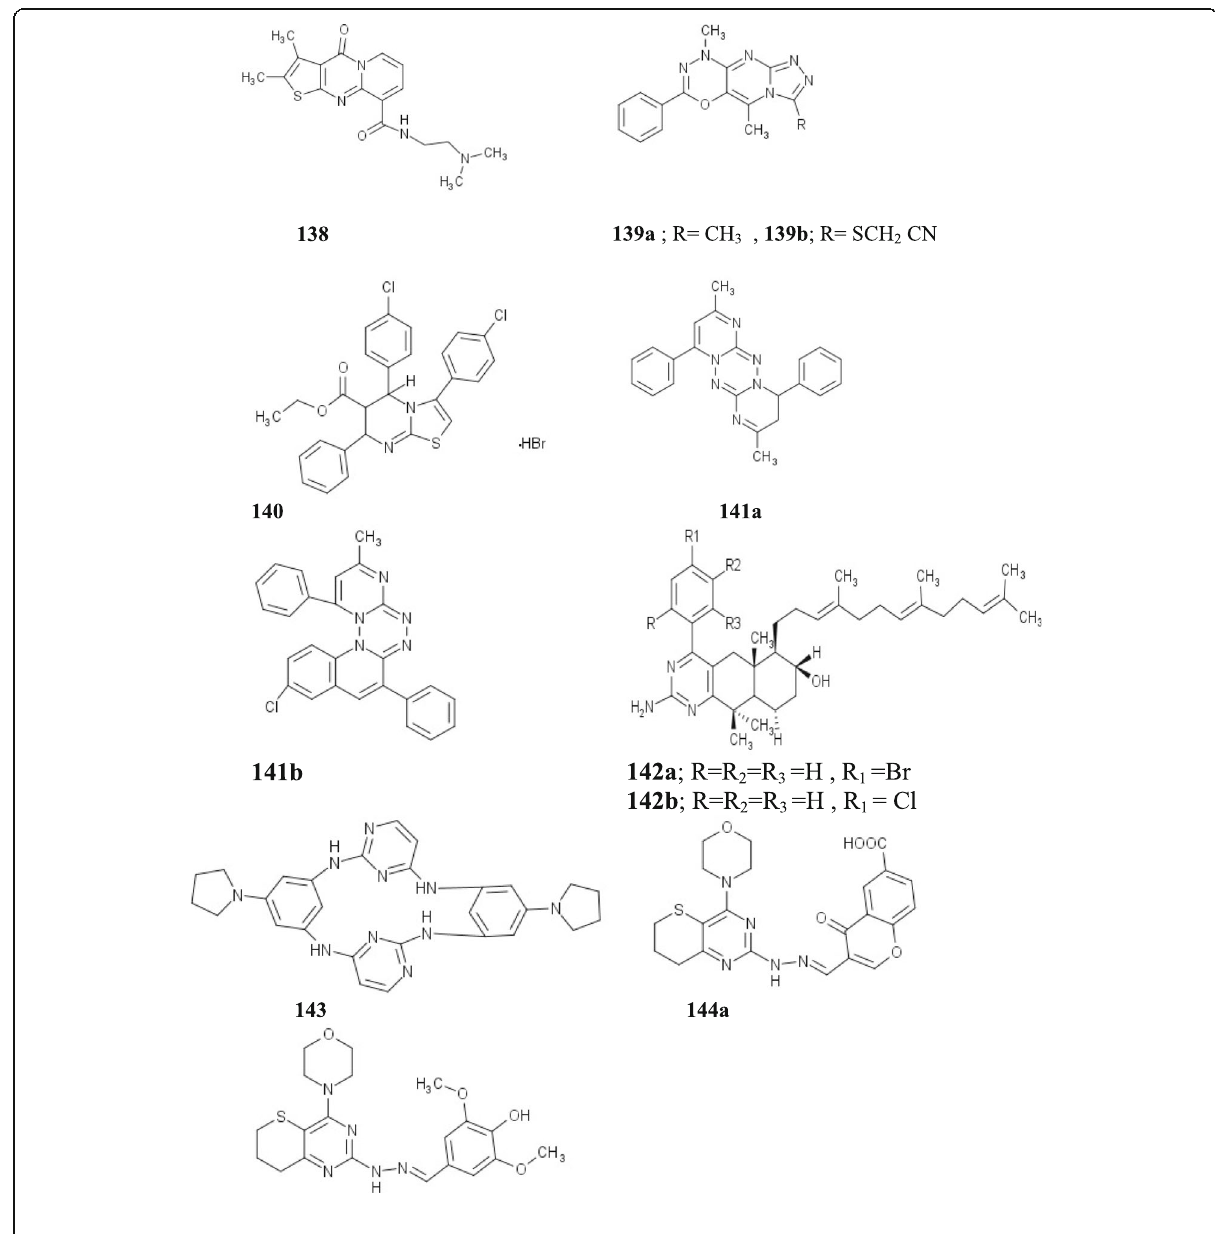
Fig. 42 Chemical structures of some miscellaneous fused ring containing pyrimidine